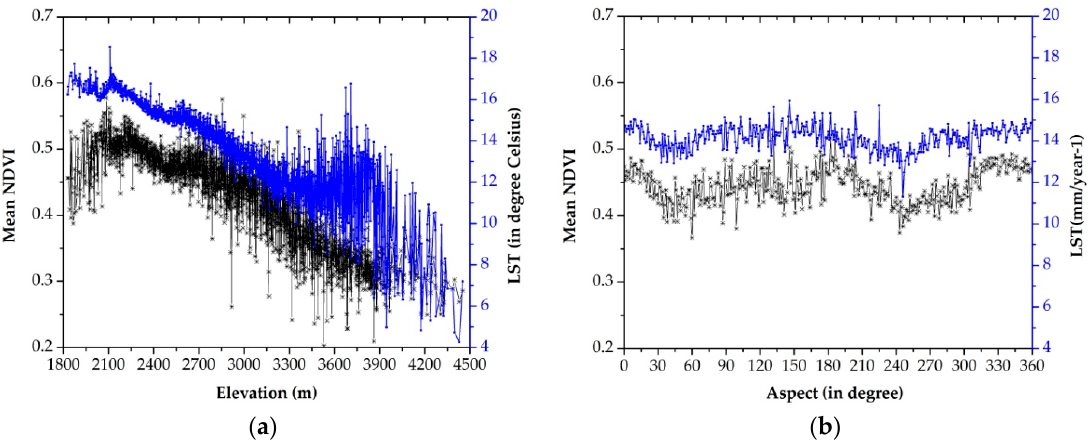
Figure 8. Scatter plot (spline connected) showing the change of NDVI with the annual LST and averaged per elevation ( a ) and per aspect ( b ).